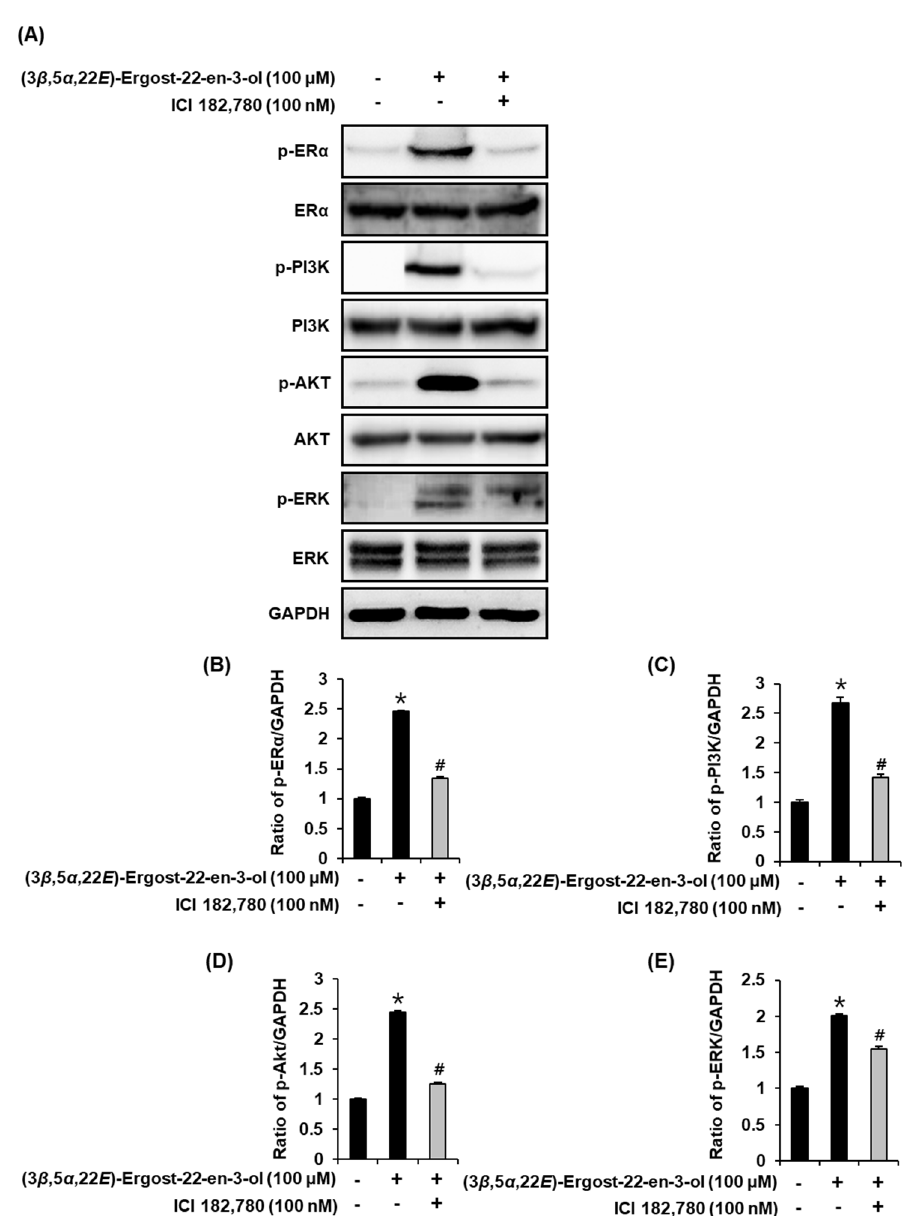
Figure 7. Effect of (3 β ,5 α ,22 E )-ergost-22-en-3-ol (compound 4 ) in the absence or presence of ICI 182,780 (ICI) on the protein expression of phospho-extracellular-signal-regulated kinase (p-ERK), ERK, phospho-phosphatidylinositol 3-kinase (p-PI3K), PI3K, phospho-Akt (p-Akt), Akt, phospho- estrogen receptor α (p-ER α ), and ER α in MCF-7 cells. ( A ) Protein expression levels of p-PI3K, PI3K, p-Akt, Akt, p-ER α , ER α , and glyceraldehyde 3-phosphate dehydrogenase (GAPDH) in MCF-7 cells treated or untreated with concentrations of 100 µM compound 4 , either with or without 100 nM ICI 182,780 (ICI) for 24 h. ( B – E ) Bar graph presents the densitometric quantification of Western blot bands. * Significant difference between cells treated with compound 4 and the untreated cells. # Significant reduction in co-treatment with ICI compared to treatment with compound 4 alone ( n = 3 independent experiments, p < 0.05, Kruskal–Wallis nonparametric test). Data are represented as mean ±